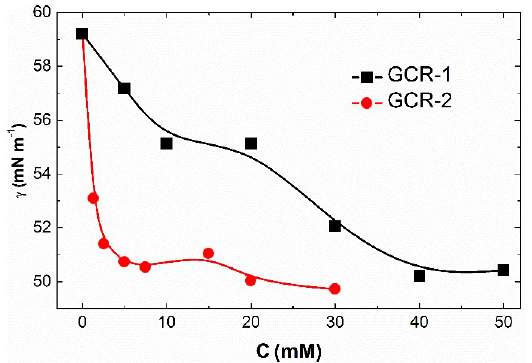
Figure 8. Isotherms of surface tension ( γ ) of calix[4]resorcinarenes GCR-1 and GCR-2 in 50% DMSO–50% water, 25 °C.